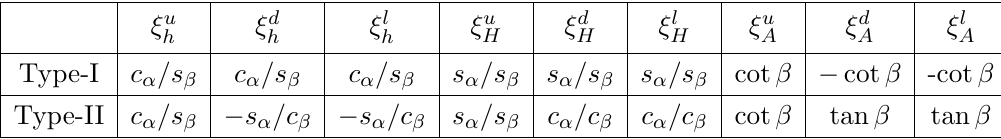
Table 1 . Scalar couplings to pairs of